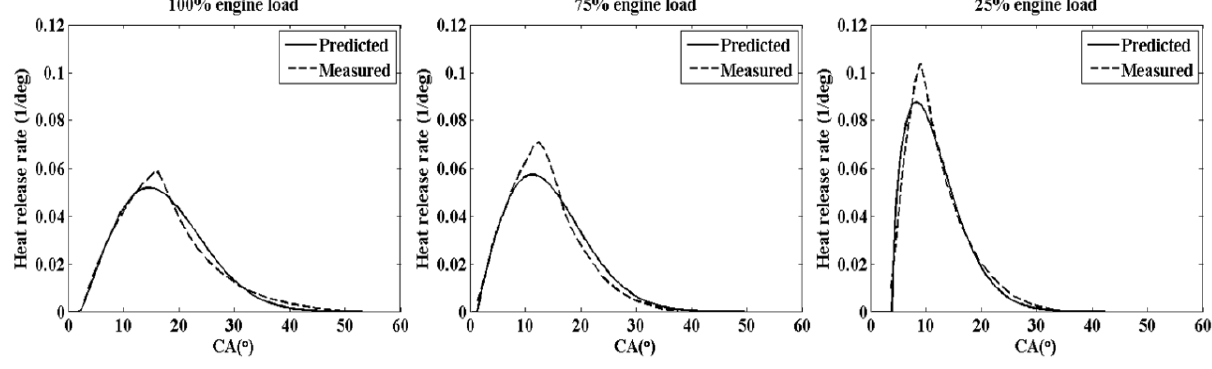
Figure 2. Heat release rates at various engine